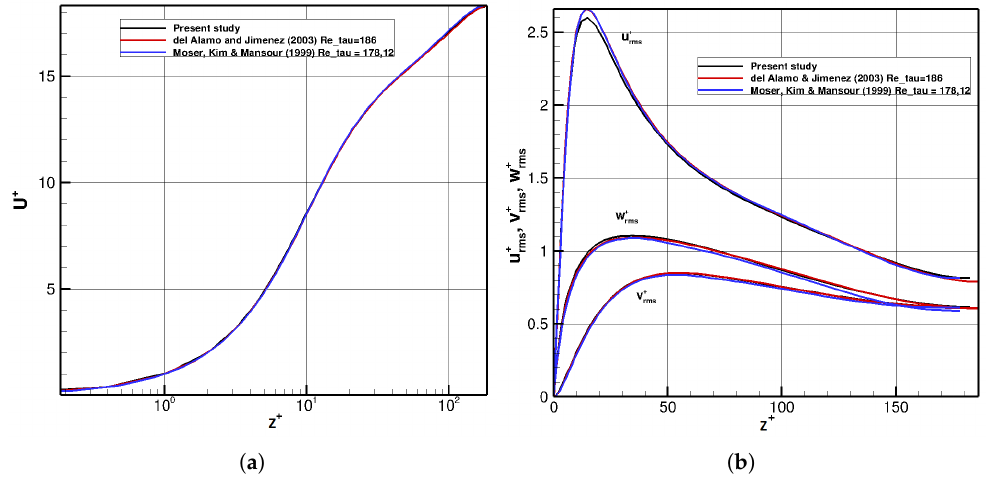
Figure 3. Canonical (planar walled) channel flow at Re = 2820 ( Re τ (cid:39) 180): ( a ) velocity average and ( b ) r.m.s. in wall units compared against results in the bibliography. u + is the dimensionless velocity: the velocity u parallel to the wall as a function of z (distance from the wall), divided by the friction velocity.